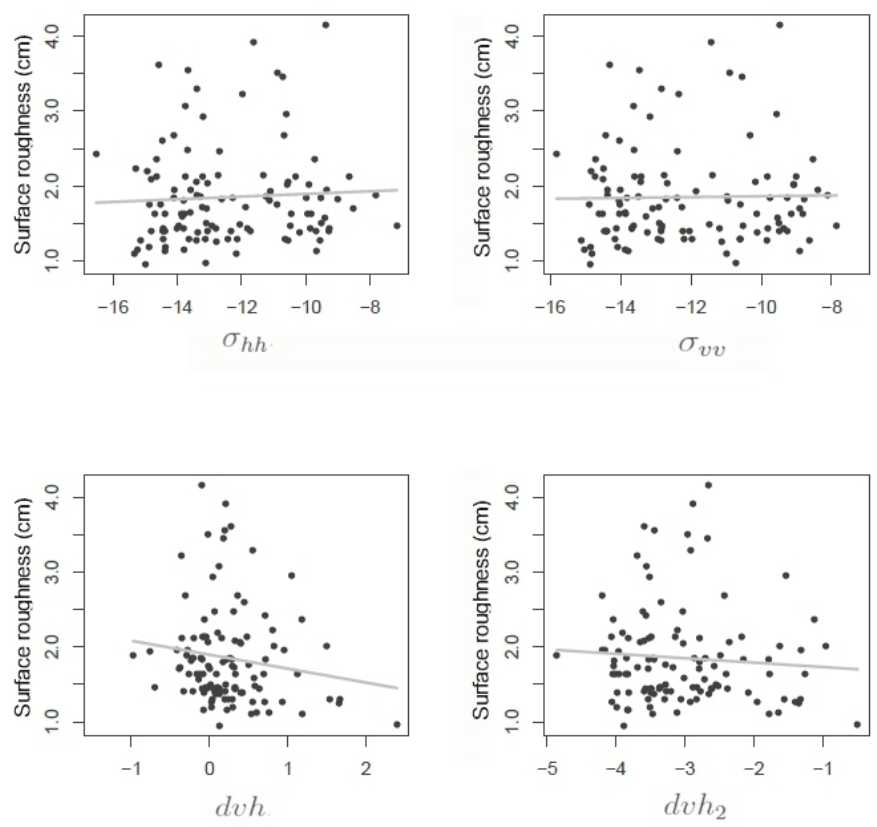
Figure 7. Scatterplots of surface roughness ( h backscatter coefficients, σ (lower panels). Best-fit regression lines are